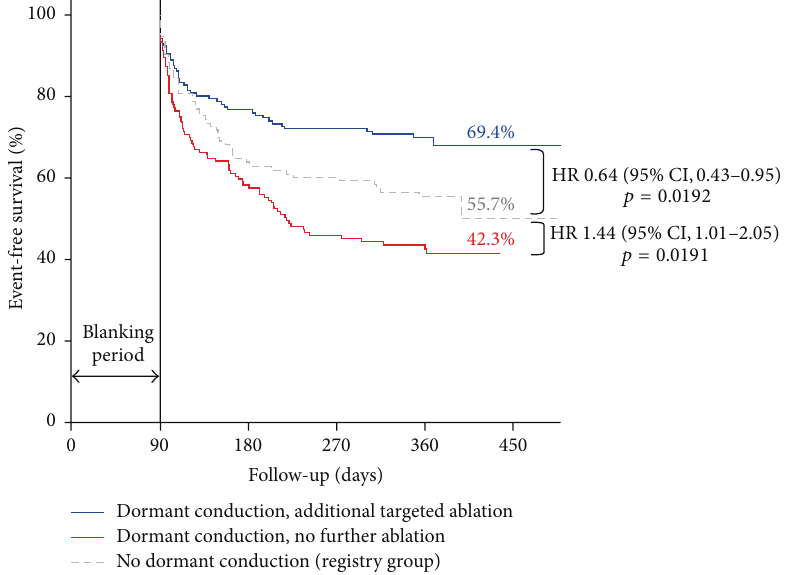
Figure 4: Freedom from symptomatic atrial tachyarrhythmia after a single ablation procedure in the ADVICE trial [9,